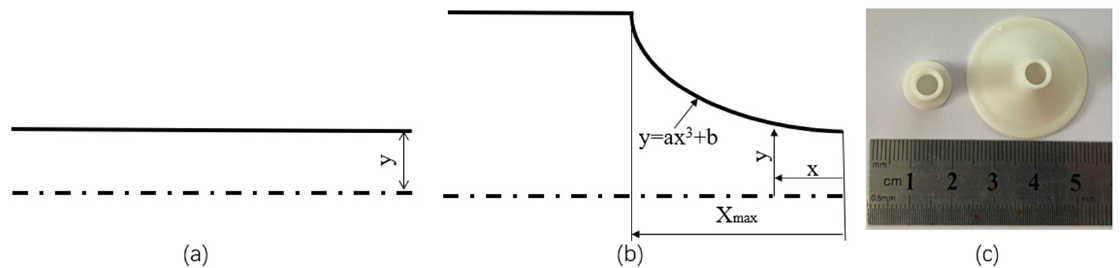
Figure 1. Structural schematic and physical diagram of the equal-diameter nozzle and standard nozzle.